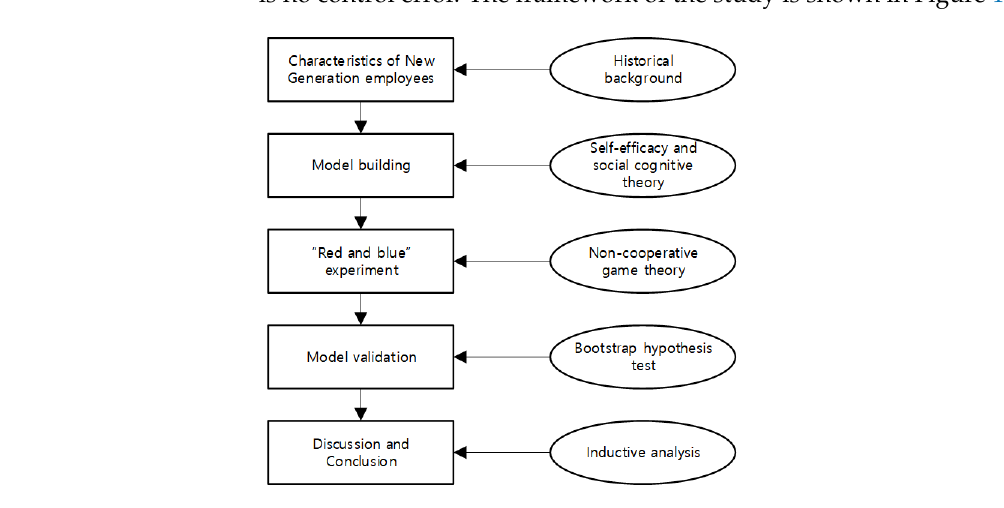
Figure 1. Framework of the